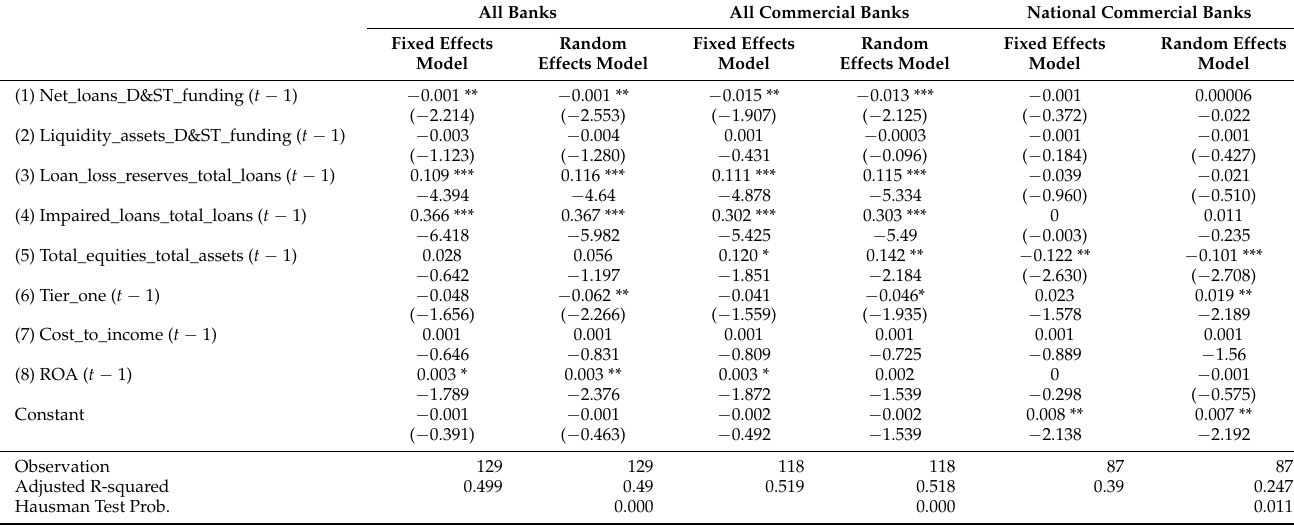
Table 11. Regression results of eight variables in t − 1